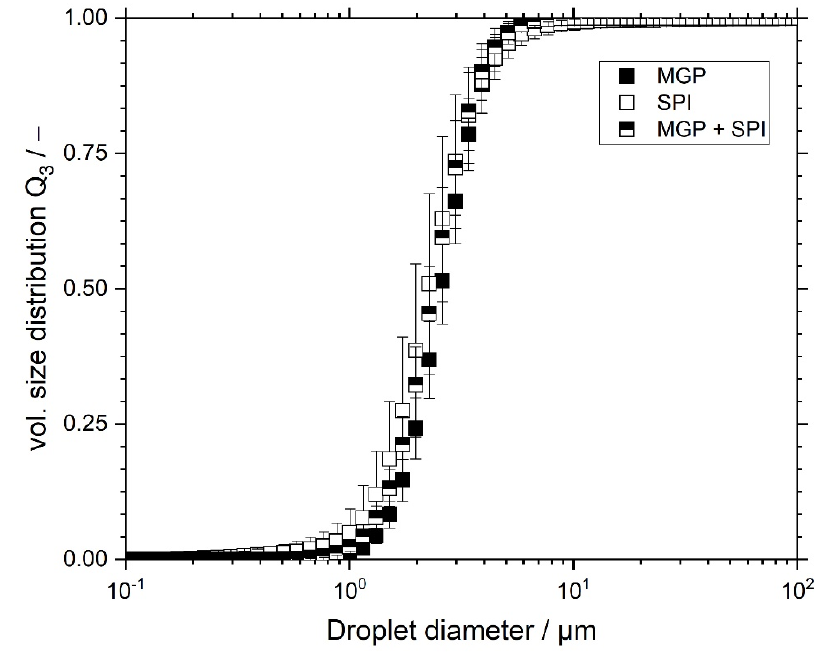
Figure 1. Coconut oil-in-water emulsions (20 wt % oil), stabilised with pectin-based microgel particles (MGP), soy protein isolate (SPI), or both in a ratio of 1:1 (MGP +